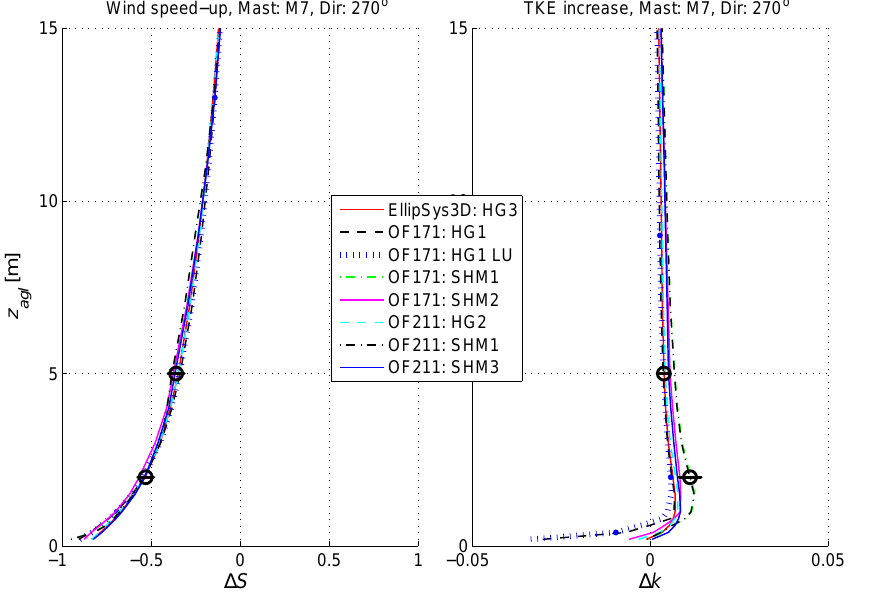
FOAM v.2.1.1 (HG2 grid) and EllipSys3D, based on an